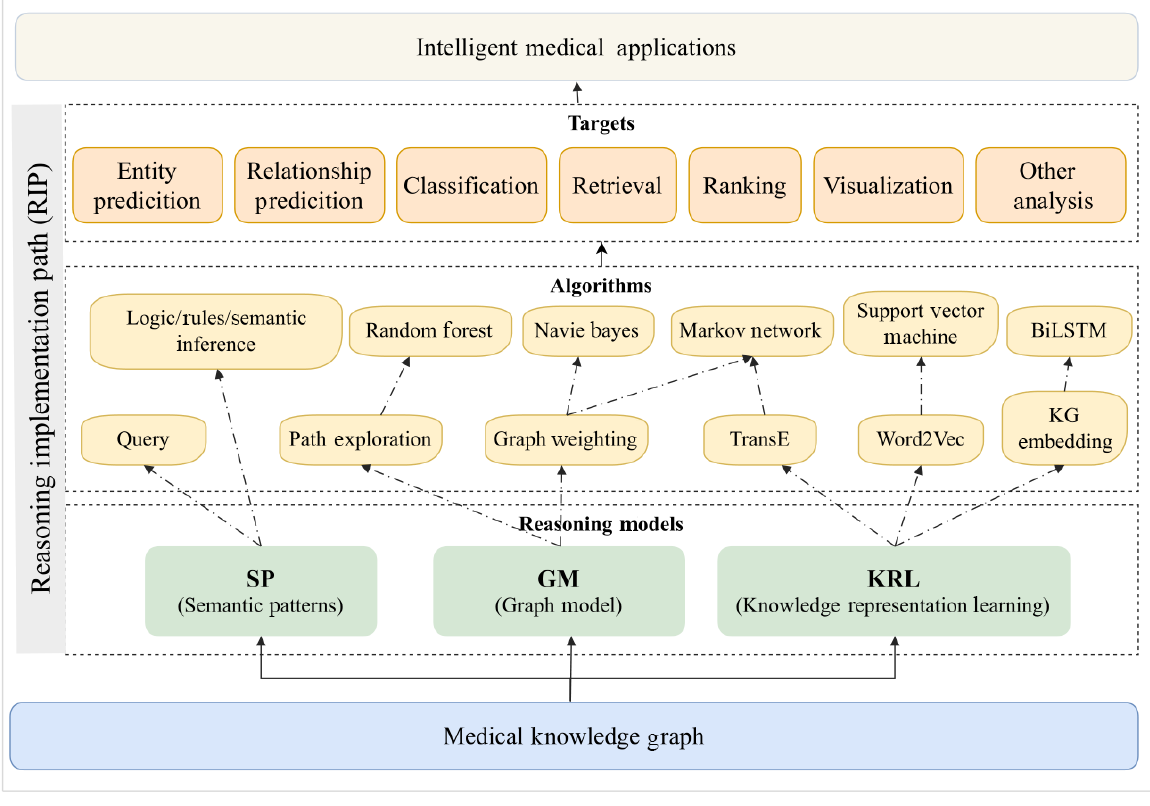
Fig. 1 Reasoning framework based on